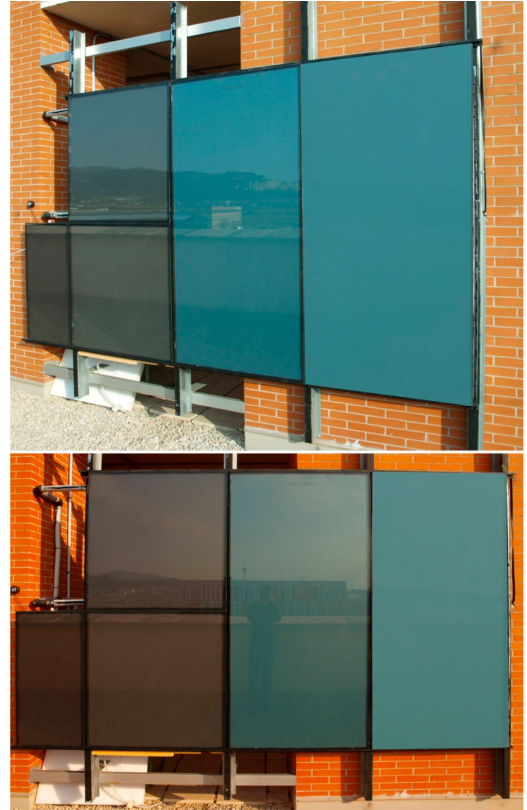
Figure 9. Front already built and active on the cover of laboratory prototype. In-phase energy data collection. Reproduced with permission from reference